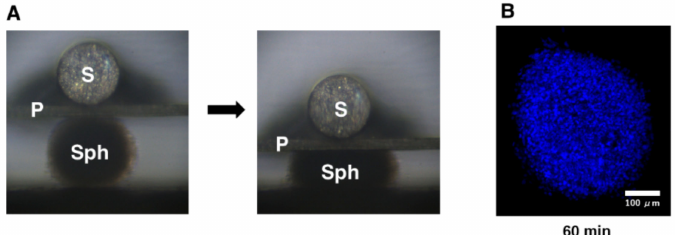
Figure 2. Mechanical compression toward 3D HTM spheroids. ( A ) Thirty 3D HTM spheroids were mechanically compressed using a micro-squeezer system (Sph: 3D sphenoid, S: pressure sensor, P: compression plate) for 10, 30, or 60 min. ( B ) Representative immunolabeling image of a 3D HTM spheroid mechanically compressed for 60 min stained with DAPI (scale bar: 100 µ m).